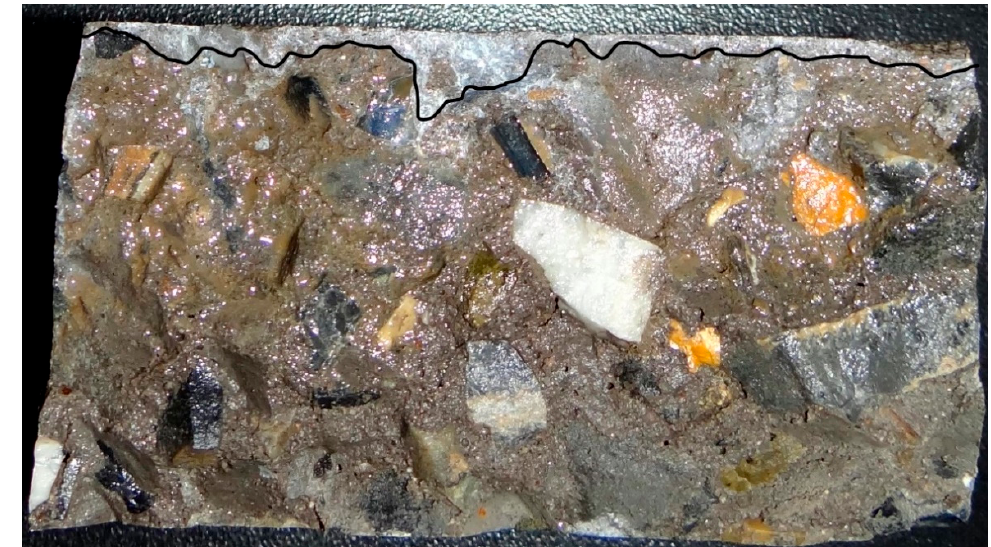
Figure 6. Distinguishing cracks using digital images. ( a ) Grey image of cracked specimens; ( b ) Crack distribution on the concrete.